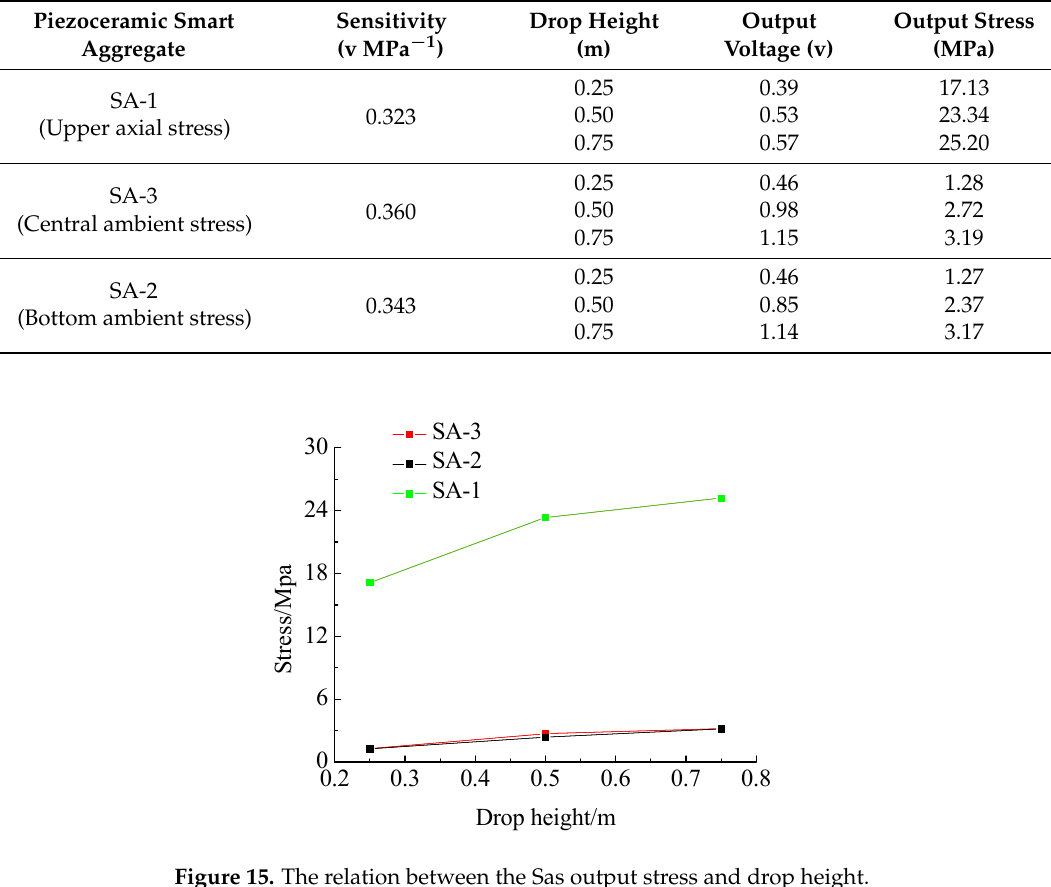
Figure 15. The relation between the Sas output stress and drop height.